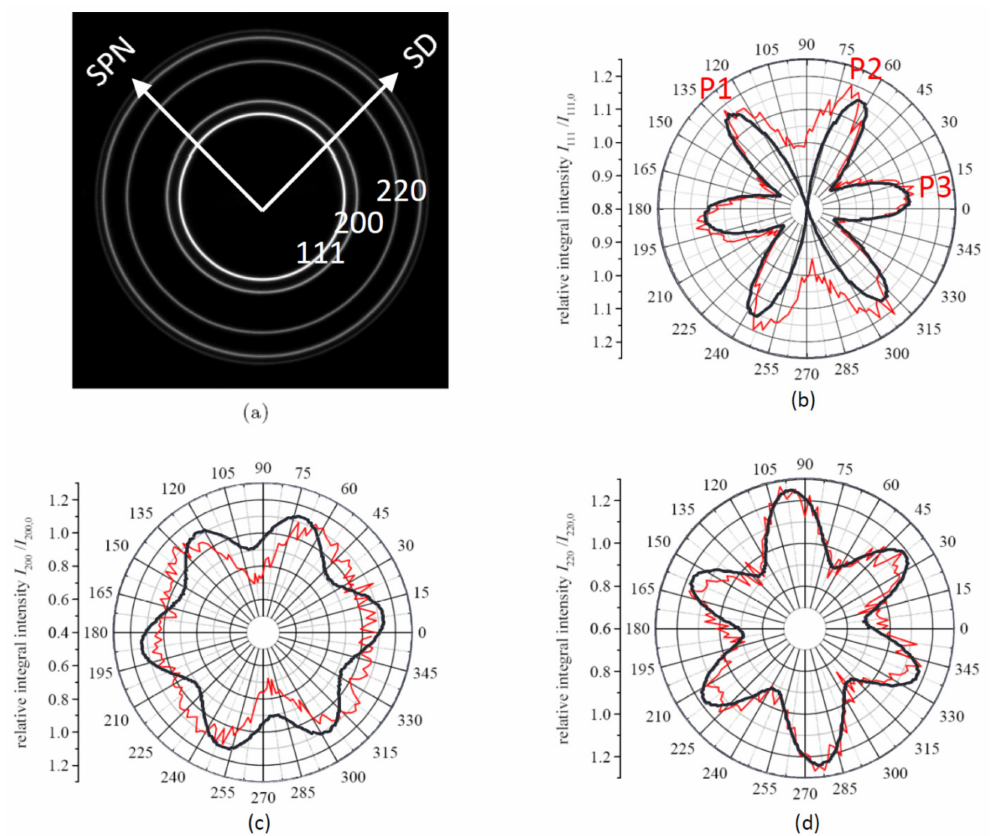
Figure 4. Experimentally measured intensity profile along the Debye–Scherrer rings ( a ) for the (111) ( b ), (200) ( c ), and (220) reflections ( d ) at a compressive strain of 0.27 applied to the gauge section in a load direction normalized with the intensity of the undeformed sample (taken from [5]). Overlaid are the simulated intensity